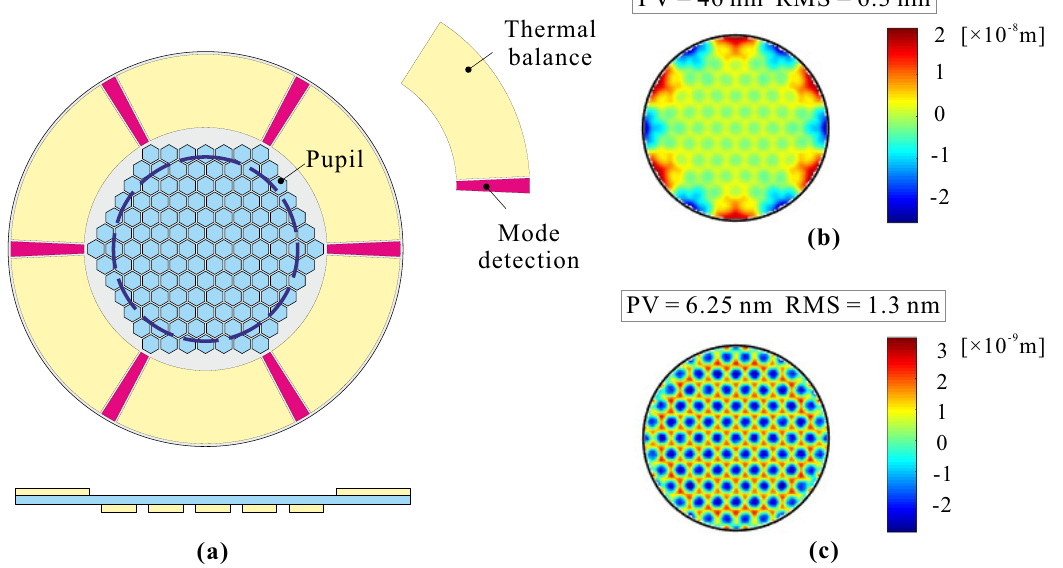
Figure 7. Active compensation of thermal deformations. ( a ) Design configuration showing the outer ring divided into 6 sectors with two electrodes each: A larger one is used as actuator for thermal control, and a smaller one is used as curvature sensor for mode detection for active damping. ( b ) Residual surface figure error in the pupil when the 6 ring actuators are used. ( c ) Residual surface figure error in the pupil when using the honeycomb and the 6 ring actuators for thermal